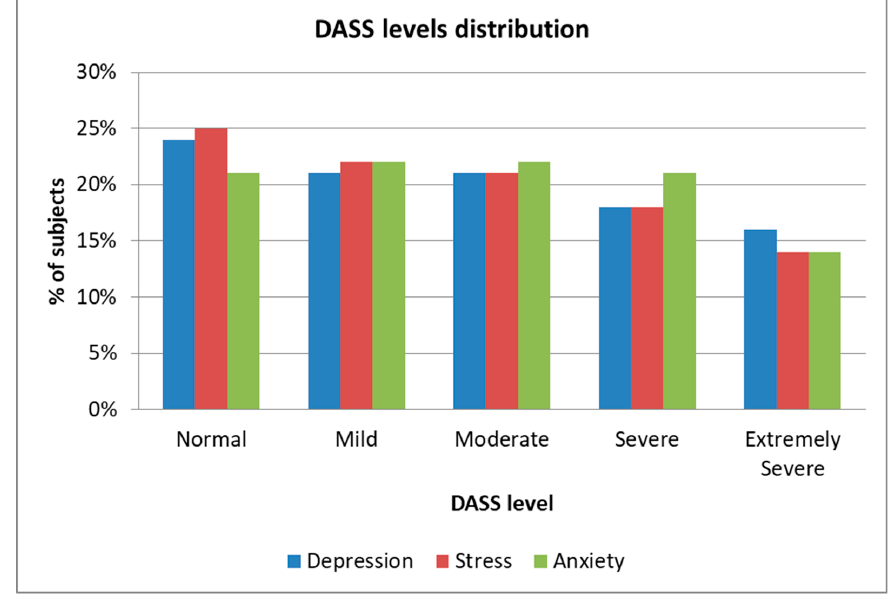
Figure 9. DASS levels distribution.